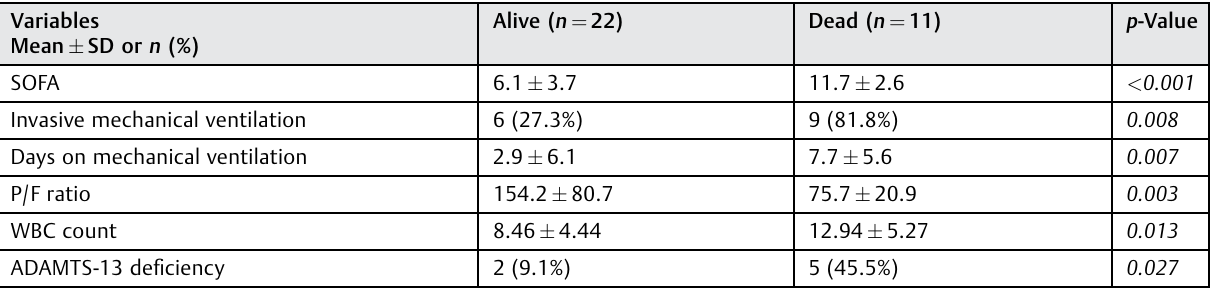
Abbreviations: SOFA, Sequential Organ failure Assessment; WBC, white blood cell.